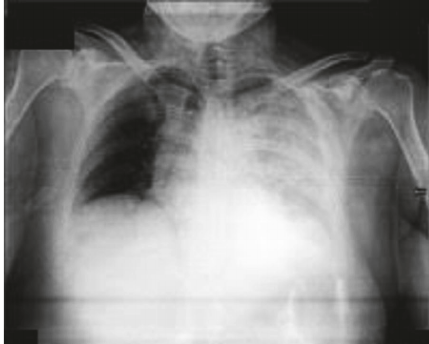
Figure 2: Chest X-ray (three hours postoperatively) demonstrating left pleural effusion.